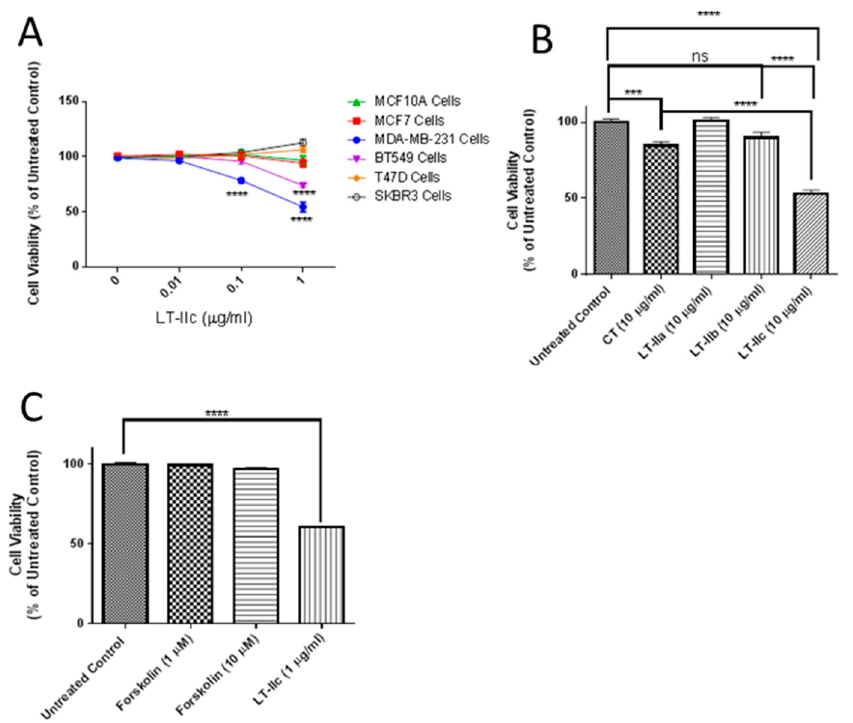
Figure 1. Effects of LT-IIc on breast cancer cell viability and morphology. ( A ) LT-IIc was specifically toxic to BT549 and MDA-MB-231 TNBC cell lines, but not MCF10A, MCF7, or SK-BR3 cells. All cell lines were treated with 0, 0.01, 0.1, 1, or 10 µg/mL LT-IIc for 48 h, followed by MTT assay. Data points represents the means ± SEM of three independent experiments. ( B ) LT-IIc, CT, LT-IIa, and LT-IIb (10 µg/mL) were tested for durable cytotoxic effects by pulsing MDA-MB-231 breast cancer cells for 24 h, followed by a wash-out period of an additional 24 h. Cytotoxicity, assessed using MTT, showed the greatest effect in cells treated with LT-IIc. Bars represent mean ± SEM from two independent experiments with eight replicates each. ( C ) The cytotoxic effects of LT-IIc enterotoxin were not mimicked by forskolin, an activator of adenylate cyclase. MDA-MB-231 cells were treated with LT-IIc (1 µ g/mL) or forskolin (1 or 10 µ M) for 48 h, followed by assessment of cell viability using MTT assay. The data represent the mean ± SEM of three replicates. Key: *** p < 0.001; **** p < 0.0001. ns